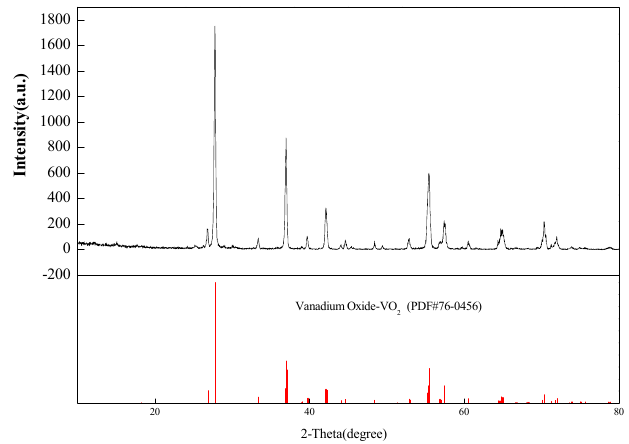
Table 3. Chemical composition of VO 2 and V 2 O 5 products.